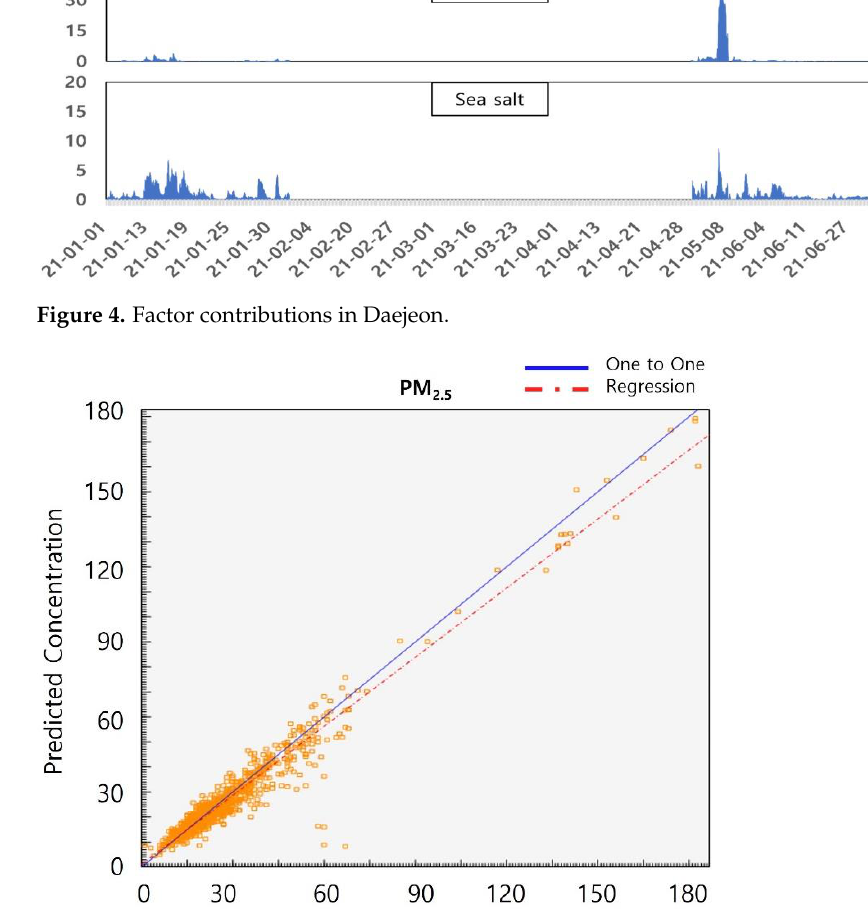
Figure 5. Scatter plot for observed and predicted PM 2.5 mass concentrations .